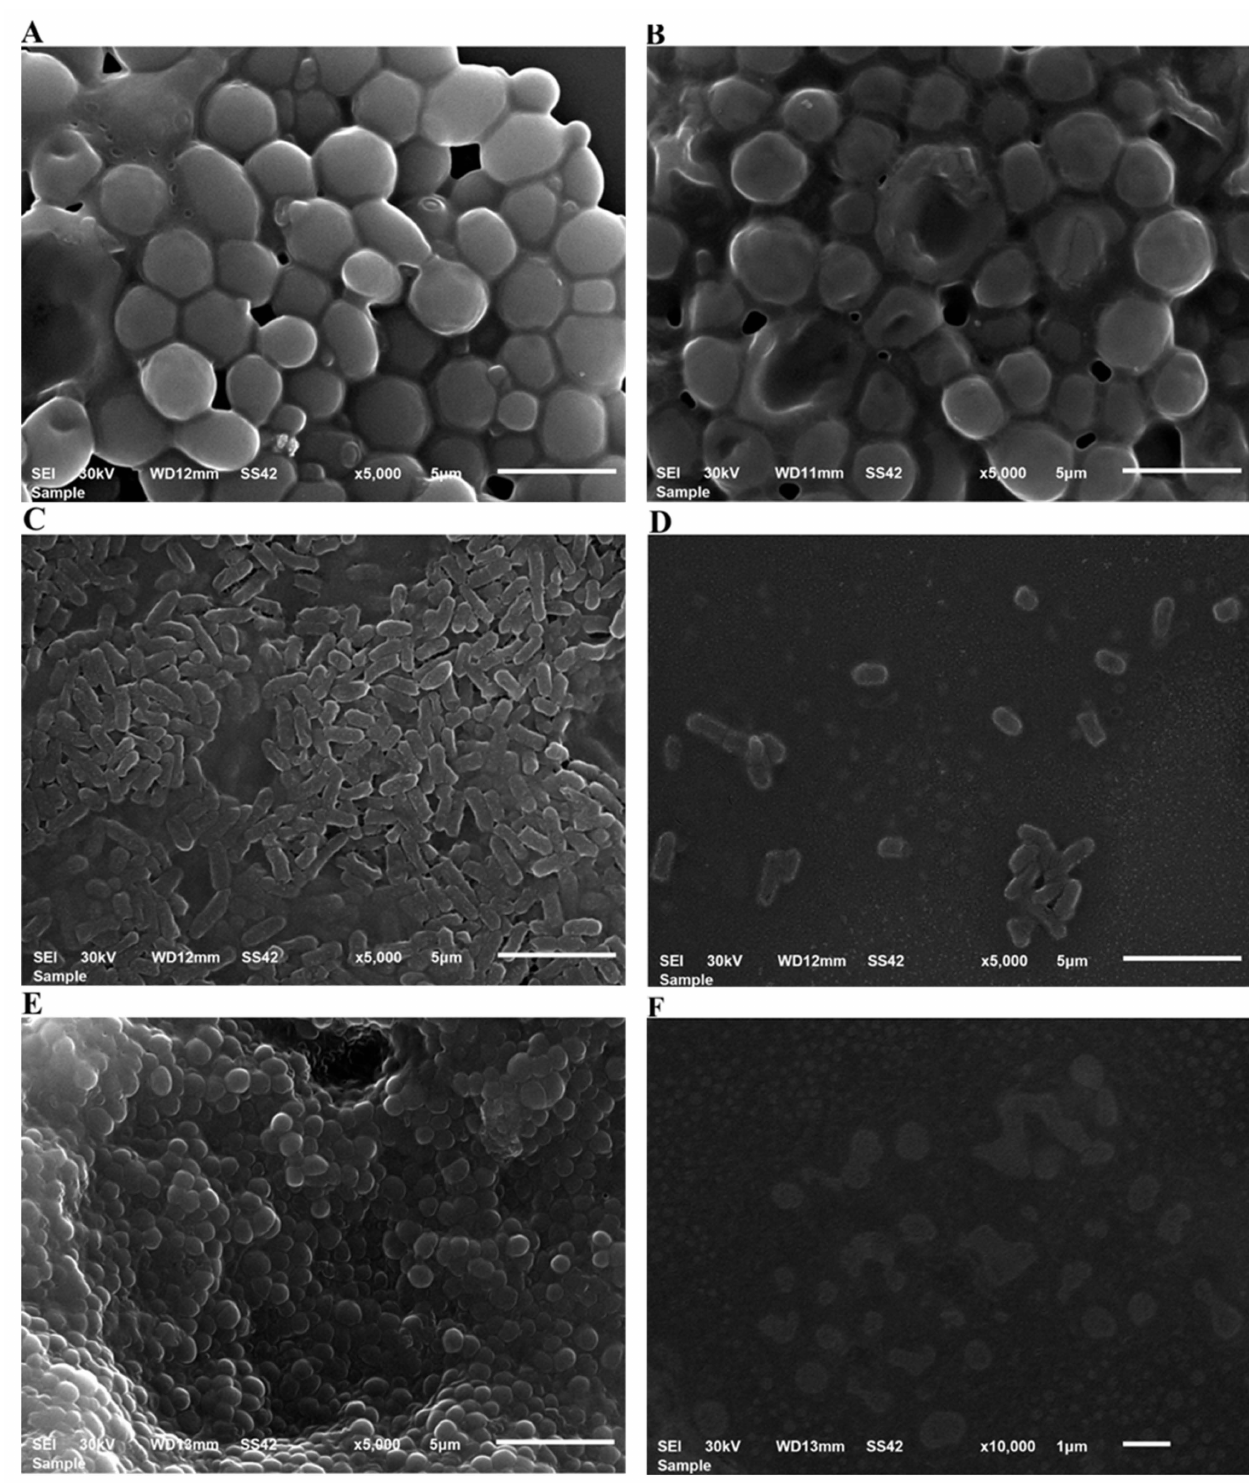
Figure 6. SEM analysis of biofilm structure. SEM images of the biofilms formed on the glass coverslips after 24 h of incubation. ( A ) Control C. albicans ; ( B ), C. albicans . treated with Au-NPs, ( C ) Control E-coli ; ( D ), E-coli treated with Au-NPs ( E ) Control S. aureus ; ( F ) S. aureus treated with